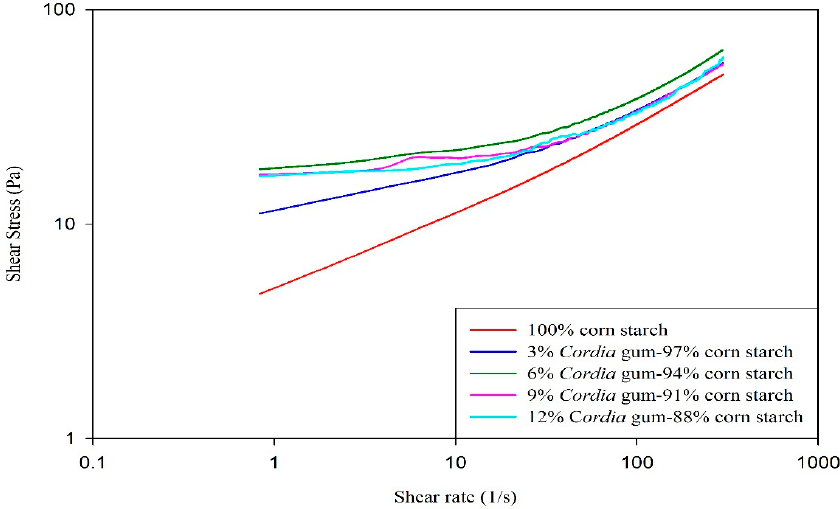
Figure 1. Effect of gum Cordia on the flow curves (shear stress) of corn starch. Figure 1. E ff ect of gum Cordia on the flow curves (shear stress) of corn starch.